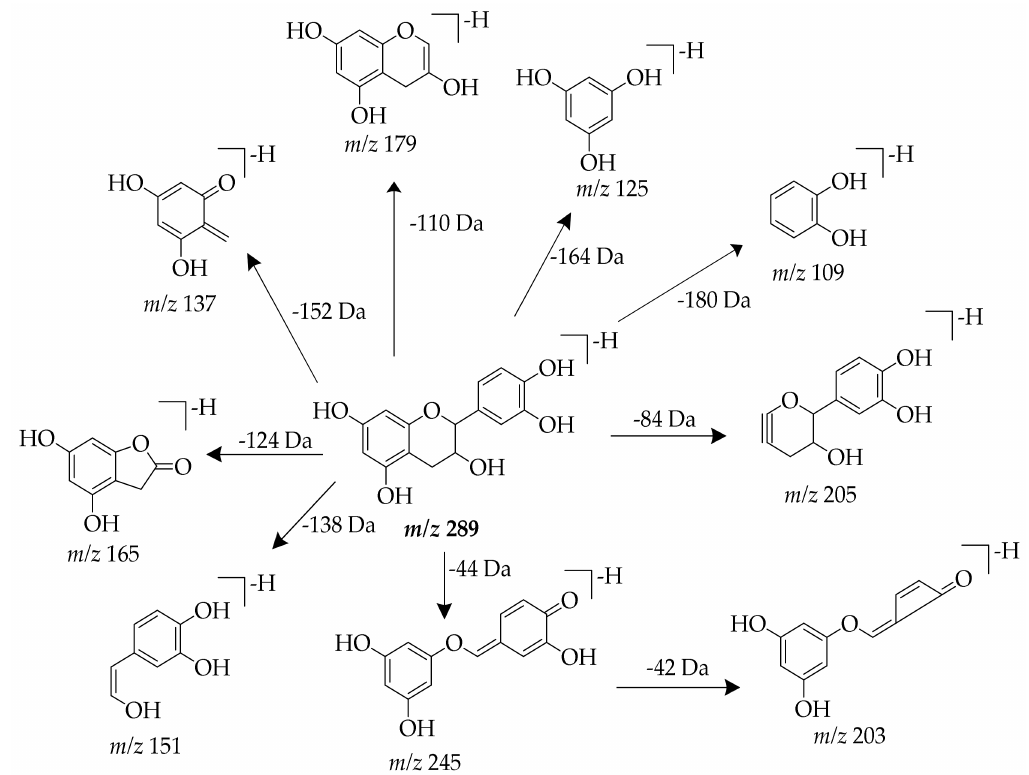
Figure 8. Proposed fragmentation pathway for catechin (peak